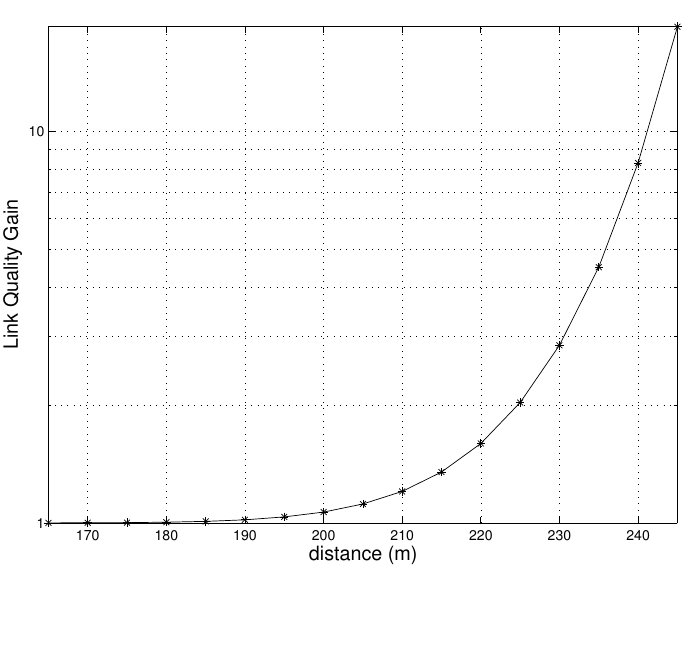
Figure 4. Link quality